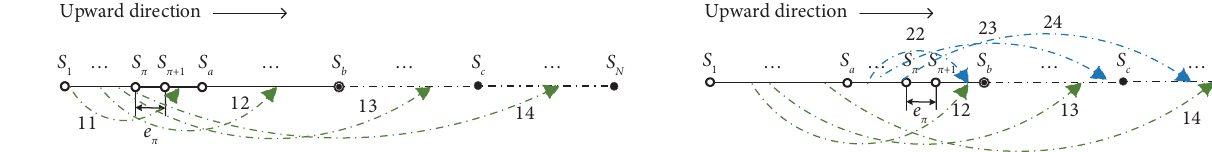
trains in section 1